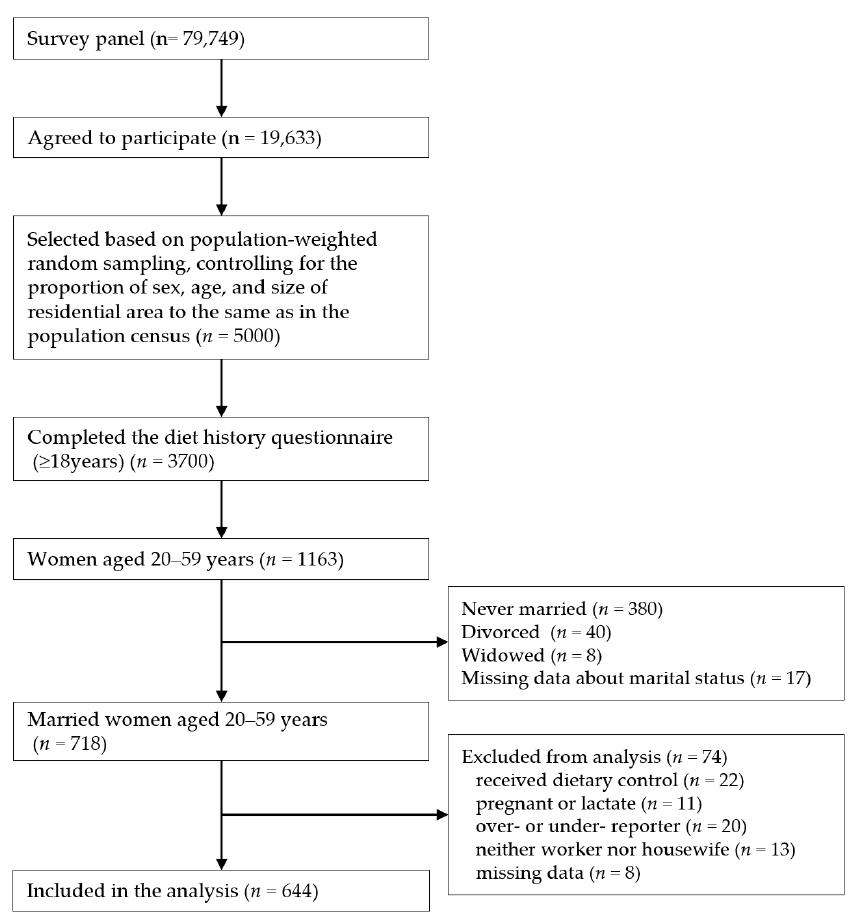
Figure 1. Study participants, comparing the dietary intake of Japanese married women with respect to hours of paid work.